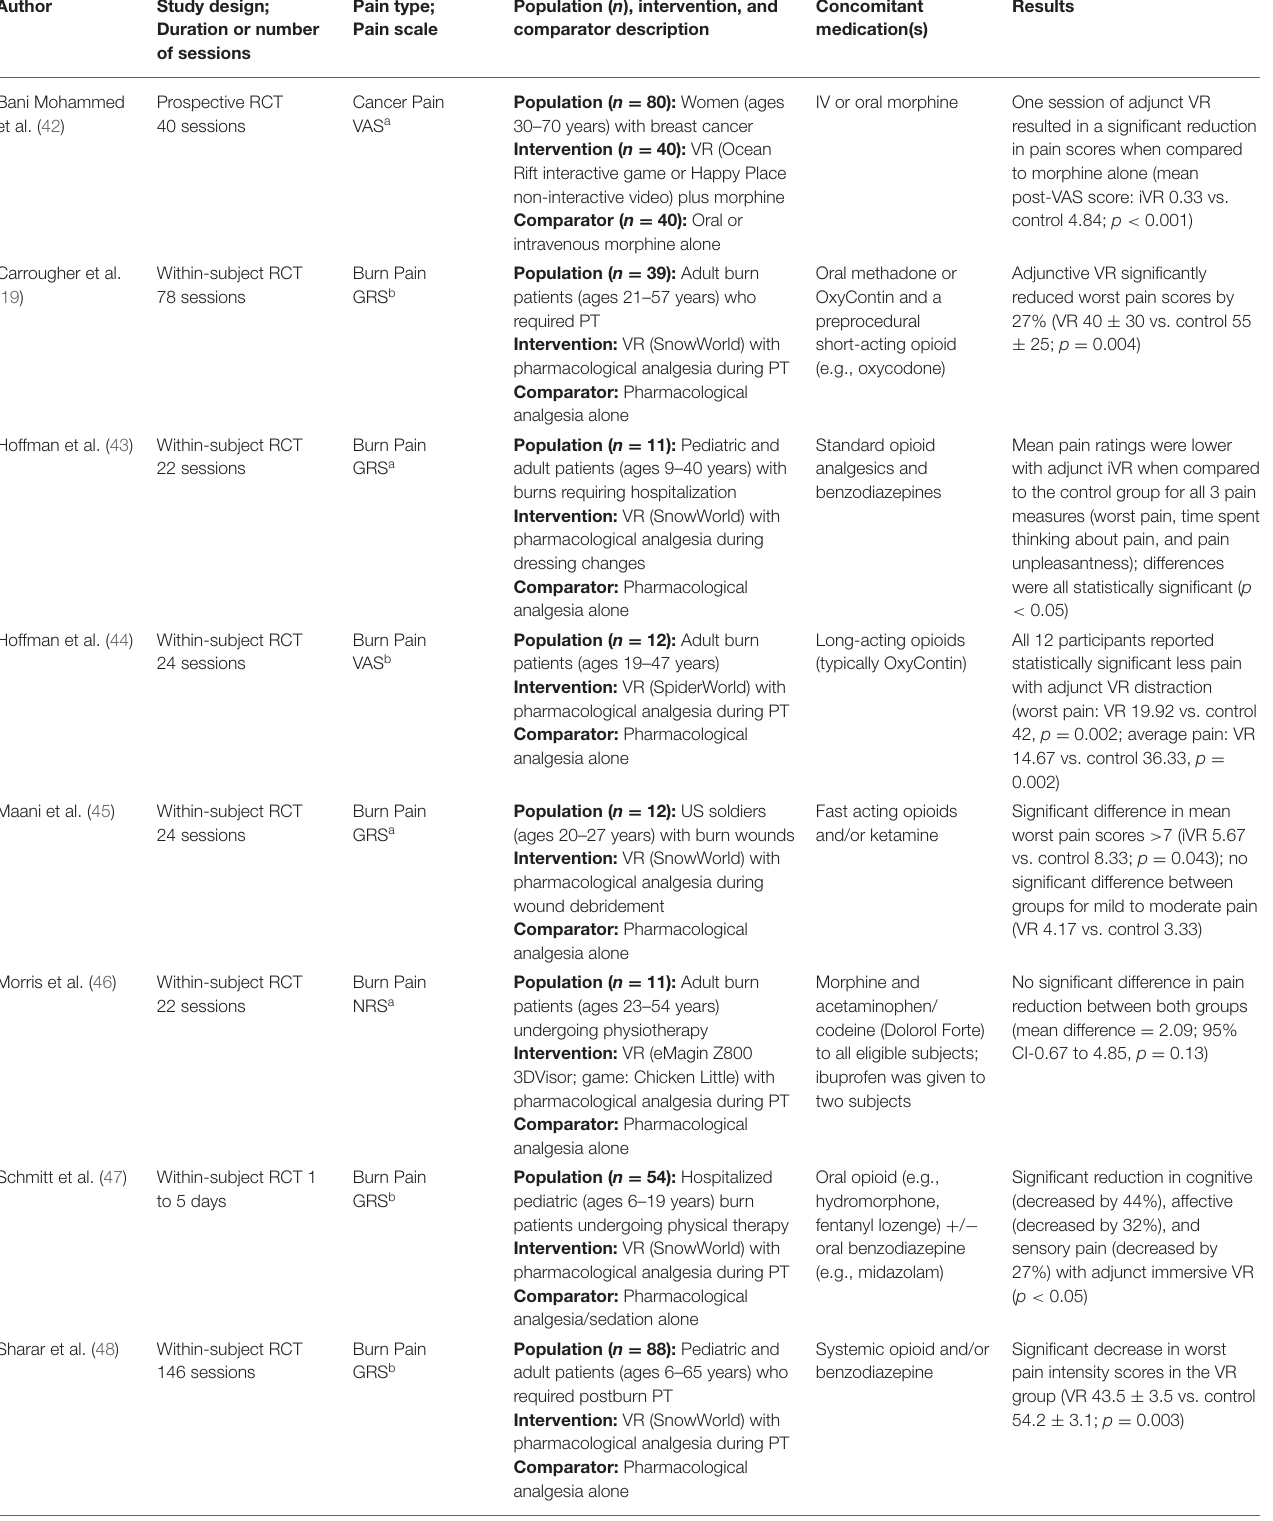
TABLE 1 | Summary of randomized controlled trials of digital interventions in patients with acute or chronic